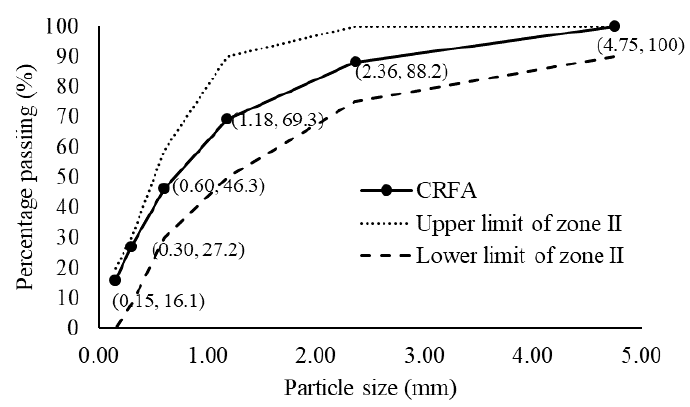
Figure 4. The particle grading curve of the produced CRFA. Table 3. The physical properties of the produced CRFA.